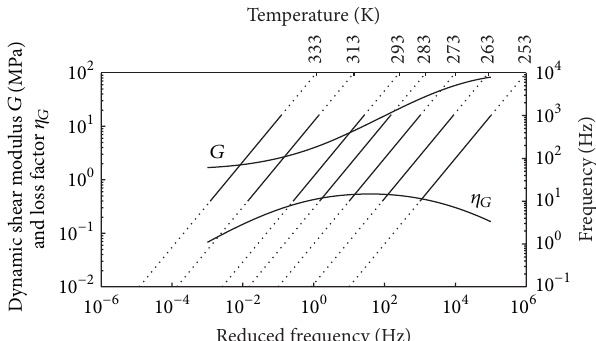
Figure 8: Viscoelastic material properties of the butyl rubber.